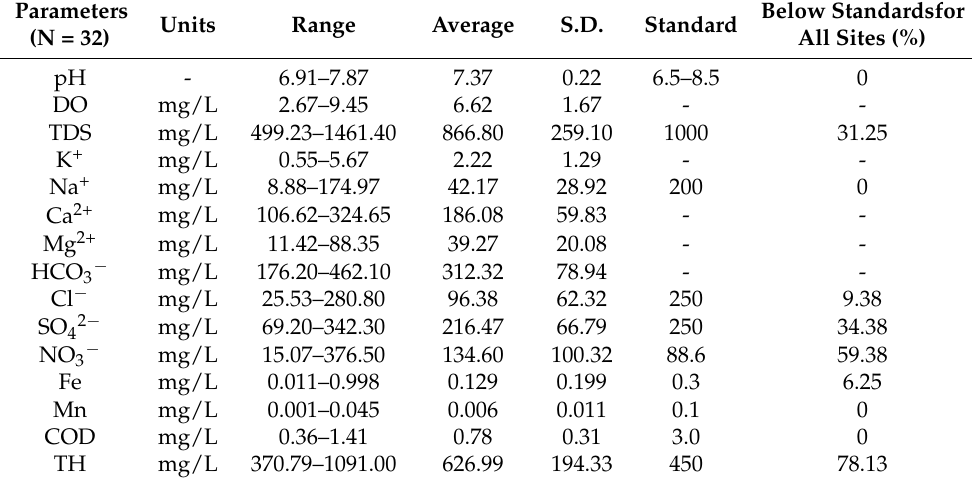
Table 2. Descriptive statistics of groundwater quality parameters along the Ye River.